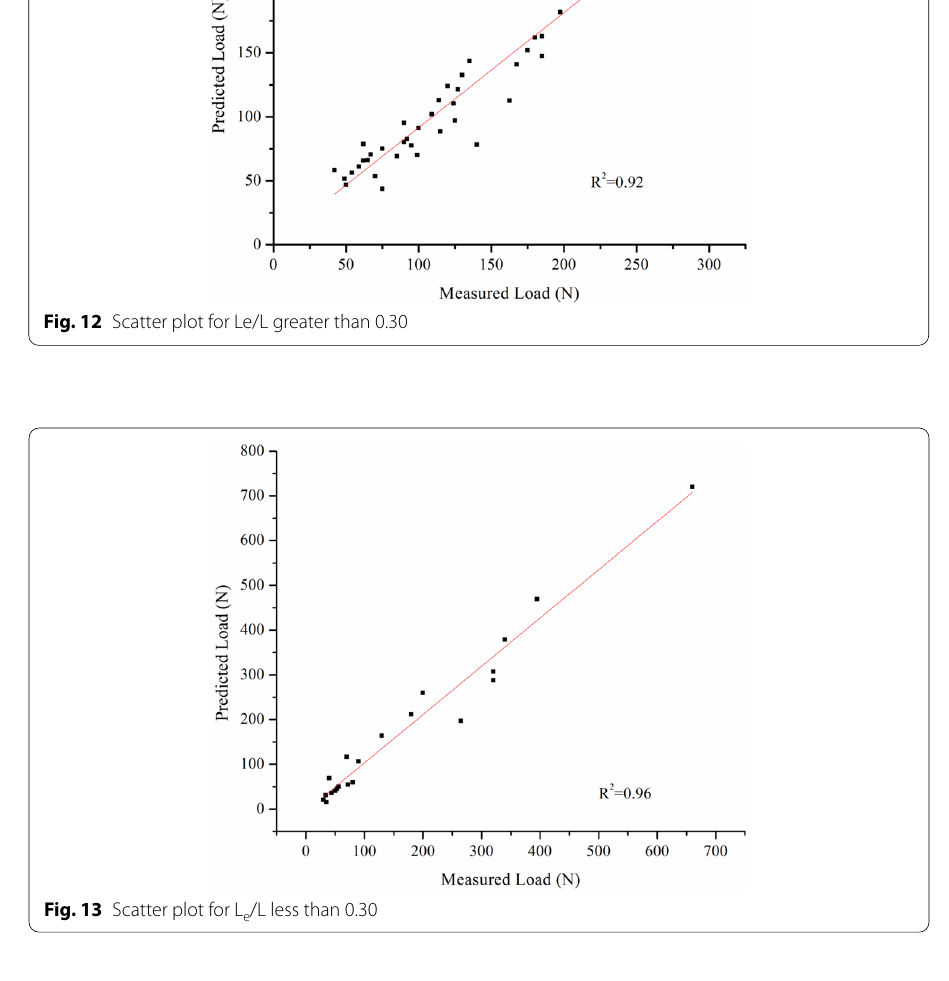
Scatter plot for actual measured lateral capacity and predicted lateral capacity using Eqs. (9) and (10) are plotted and presented for Le/L greater than 0.30 and less than 0.30 in Figs. 12 and 13 respectively. The regression coefficient (R 2 ) was obtained as 0.92 and 0.966 for Eqs. (9) and (10) respectively, which means that the predicted values of lateral pile capacity of socketed pile are very well agree with experimen- tal values of socketed piles. It should be noted that the above equations were devel- oped based the experimental test results (1-g) on model pile made of aluminium tube under low confining stress conditions in unsaturated cohesionless sand as top layer and concrete as bottom rock layer. Therefore, the application of the above equations is limited to the selected parameters.